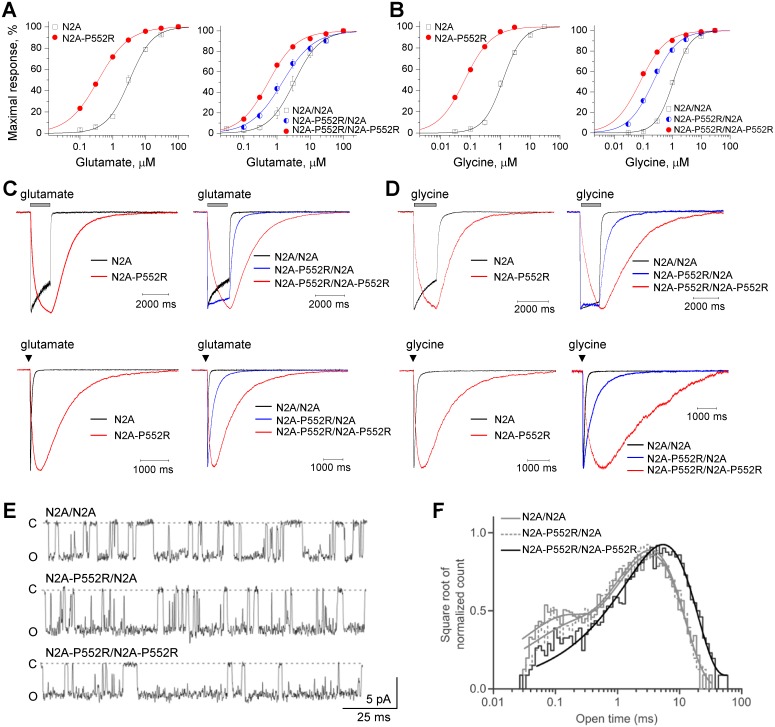
GluN2A-P552R increases agonist potency and alters the NMDAR response time course.A, Steady-state concentration-response relationship for glutamate activation of human di-heteromeric (left panel) GluN1/GluN2A receptors and rat tri-heteromeric GluN1/GluN2A (right panel) containing 0, 1, or 2 copies of GluN2A-P552R receptors (labelled N2A/N2A, N2A/N2A-P552R, N2A-P552/N2A-P552R) expressed in Xenopus oocytes with 100 μM glycine present in all solutions. B, Concentration-effect relationship for glycine activation of human di-heteromeric (left panel) and rat tri-heteromeric (right panel) GluN1/GluN2A and GluN1/GluN2A-P552R receptors with 100 μM glutamate present in all solutions. C, Whole cell voltage clamp recording of di-heteromeric (left panels) and tri-heteromeric (right panels) GluN1/GluN2A-P552R receptor responses to rapid application of long (1.5 sec, upper panels) and brief (5 ms, lower panels) application of 1000 μM glutamate; saturating glycine (30 μM) was present in all of the solutions. Fitted parameters describing the time course of the response to long glutamate application are given in Table 4. The rise time and weighted tau describing the response to brief 5 ms application of glutamate were 7 ± 0.7 and 42 ± 4.3 ms for WT GluN1/GluN2A and 146 ± 20 and 689 ± 49 ms for diheteromeric GluN1/GluN2A-P552R, respectively (p < 0.0001 for both, t-test, n = 7–9). The rise time and weighted tau for receptors with 0, 1, or 2 copies of GluN2A-P552R were 8 ± 1and 38 ± 3.4 ms, 9 ± 1 and 201 ± 30 ms, 210 ± 16 and 1283 ± 153 ms, respectively (n = 8). D, Whole cell voltage clamp recording of di-heteromeric (left panels) and tri-heteromeric (right panels) GluN1/GluN2A-P552R receptor responses to rapid application (1.5 sec) of glycine; saturating glutamate (100 μM) was present in all of the solutions. See Table 4 for all mean ± s.e.m. values and S5 Table for statistical analyses for panels A-D. E, Single channel currents were recorded from HEK293 Tet-On cells selectively expressing GluN1/GluN2A receptors with 0, 1 or 2 copies of GluN2A-P552R. Currents were recorded in the outside-out configuration at -80 mV. The closed state (C) is indicated by a dashed line and openings are downwards deflections of current and the open state is indicated by an O. F, Normalized open time histograms from the three current recordings shown in (E) reveal an increase in the slower open time component of GluN1/GluN2A-P552R. Smooth lines show fitted dual component exponential functions. See also S2 Fig.